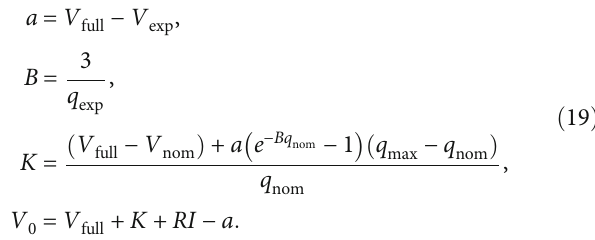
Figure 10 indicates both annual PV solar output power and storage battery input power of the stand-alone